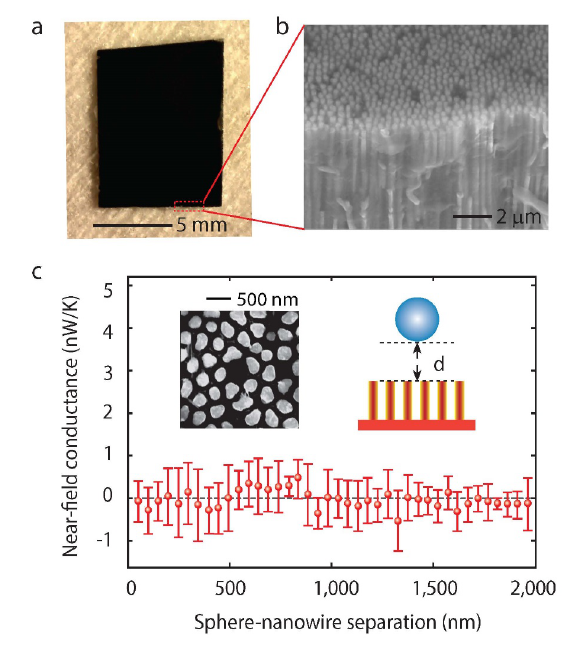
Figure 9: Fabrication of a hyperbolic metamaterial (HM) composed of metal wire arrays (MWAs) and its application as low-loss waveg- uides. (a) Optical image of the polished nickel nanowire-anodic alu- minum oxide (AAO) composite. (b) SEM image of the side view of the polished sample shown in (a). (c) Near-field heat transfer between an SiO 2 sphere and free-standing nanowire arrays as a function of nanowire-sphere separation. The dashed line indicating zero near- field conductance is drawn for eye guidance. The upper left inset is the SEM image of the top view of free-standing nanowires, where the nanowires are well separated from each other after supercritical drying [9].